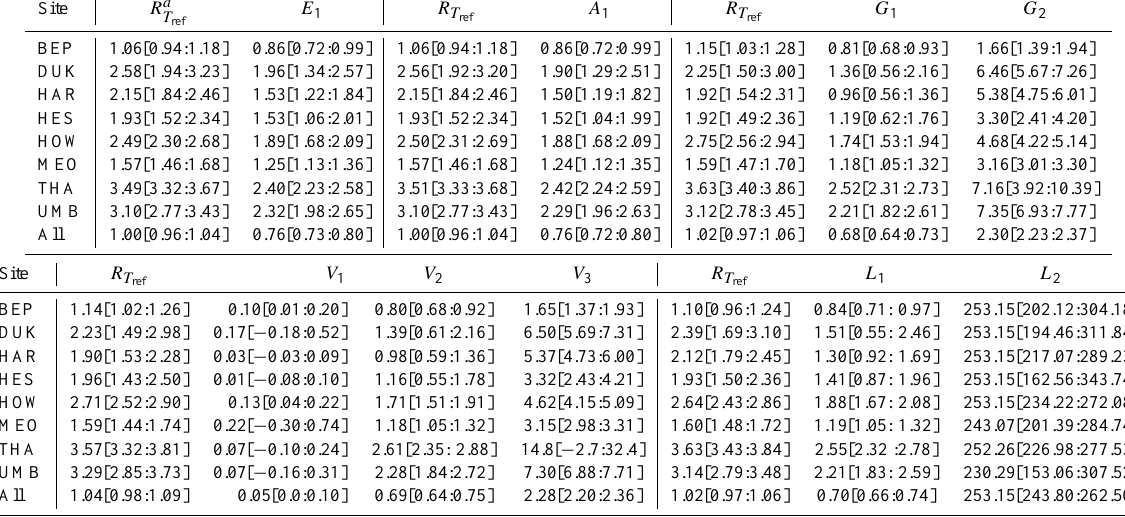
Table A3. Model parameter